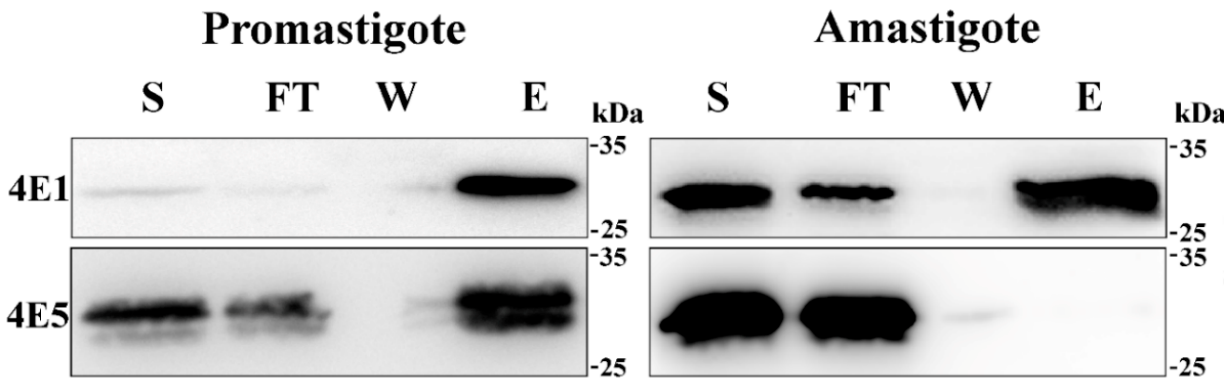
Figure 4. LeishIF4E-5 binds to the cap analog m 7 GTP only during the promastigote stage. Transgenic L. amazonensis promastigotes expressing SBP-tagged LeishIF4E-5 were lysed and incubated with m 7 GTP-agarose beads. The beads were washed and eluted using 200 µ M free m 7 GTP. Samples from the eluted protein fractions and washes were precipitated by 10% trichloro-acetic acid (TCA). The gels were loaded with samples of the total supernatant (S, 2%), flow-through (FT, 2%), the wash (W, 50%) and the eluted fractions (E, 50%). The proteins were resolved over 12% SDS-PAGE and analyzed using specific antibodies against the SBP-tag to identify LeishIF4E-5 and antibodies raised against LeishIF4E-1. Similar results were obtained from three independent experiments. Densitometric analysis of the cap-binding activity in promastigotes is given in Figure S 5 .